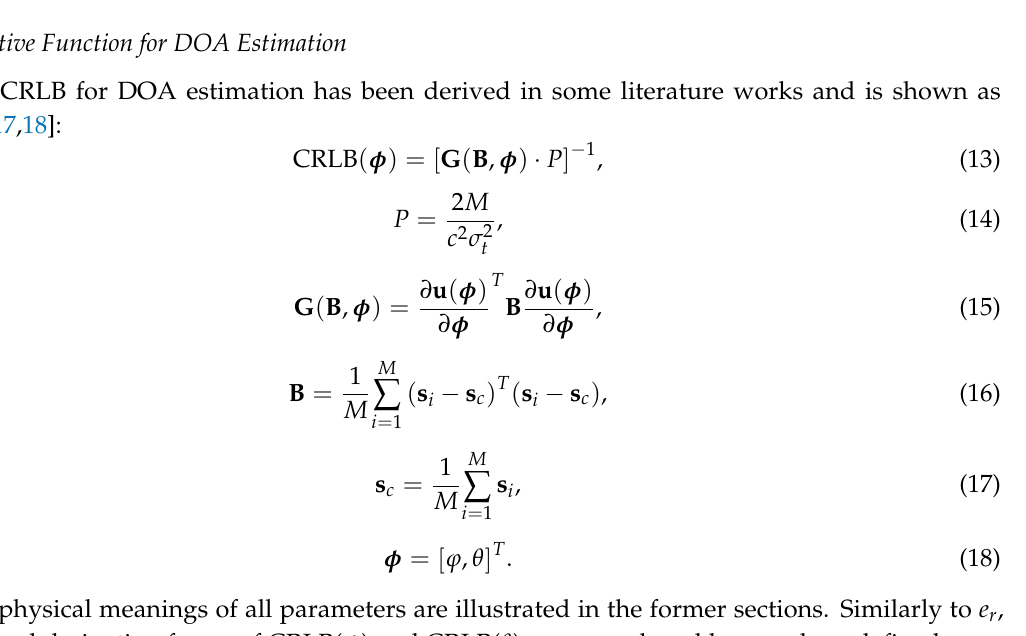
Figure 2. Schematic diagram of objective function for coordinate estimation: ( a ) square array; ( b ) an arbitrary array.